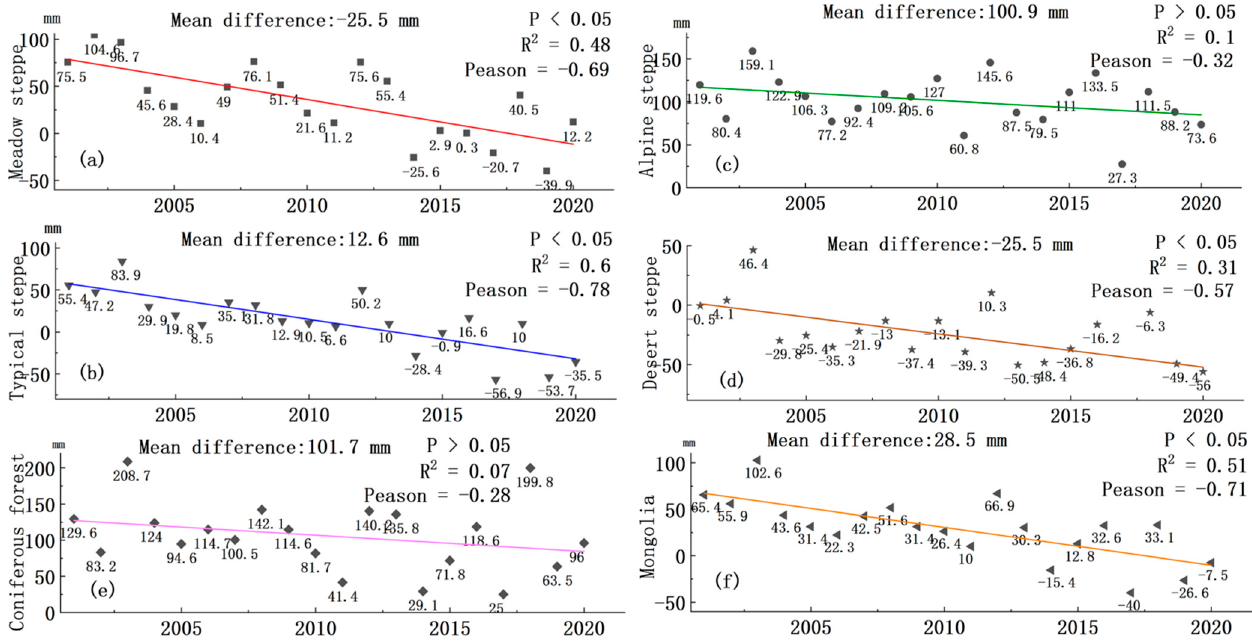
Figure 3. Difference in Pre and ET in different vegetation types from 2001 to 2020: ( a ) meadow steppe,